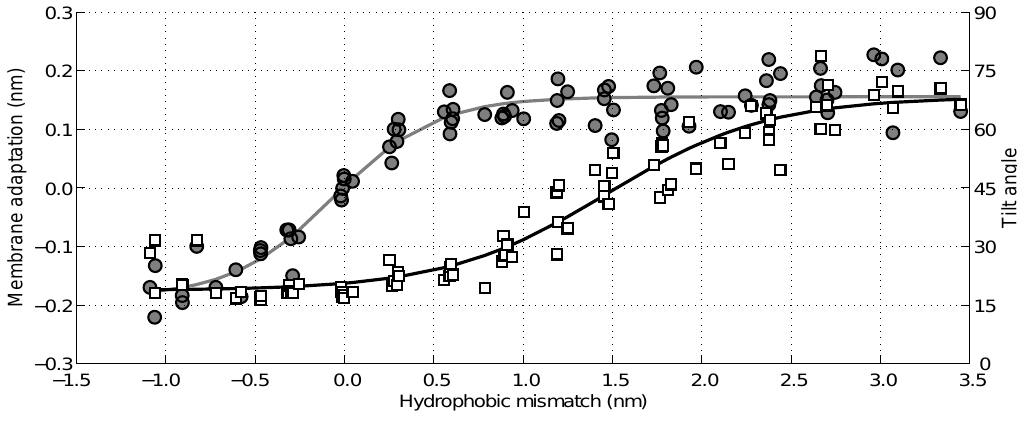
Figure 10. The effect of hydrophobic mismatch on peptide tilt and membrane adaptation. The membrane adaptation is shown by the circles and indicated on the left vertical axis, while the peptide tilt is on the right vertical axis and shown with squares. The lines are sigmoid curves fitted to the data and are only to guide the eye; both lines have a regression coefficient of